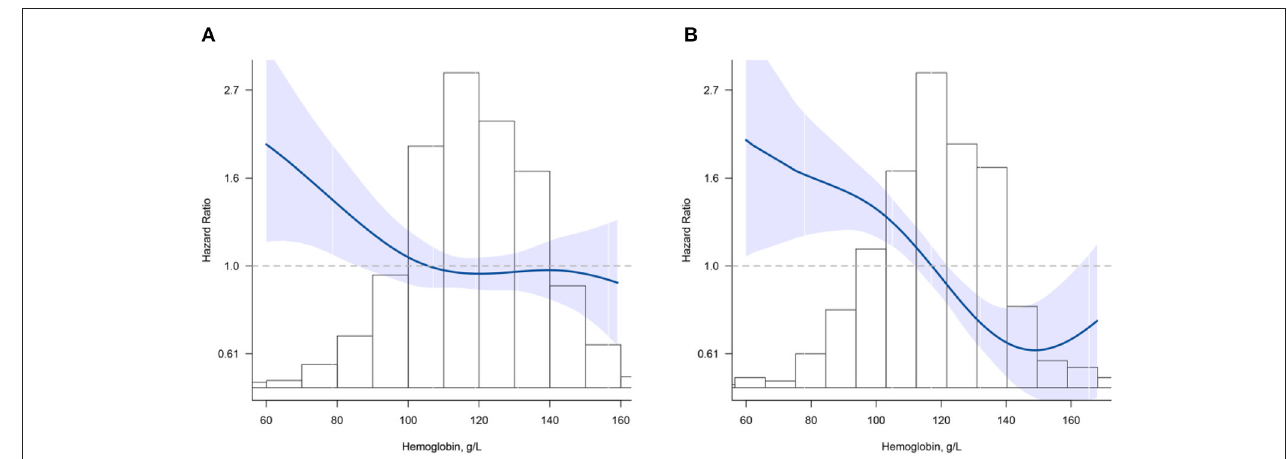
FIGURE 2 | Association between hemoglobin (Hb) and all-cause mortality according to cognition impairment. (A) normal cognitive group; (B) cognition impairment group. Hazard ratios are indicated by blue solid lines and 95% CIs by shaded areas. Histogram represents the distribution of Hb. Model was adjusted for age, sex, education, marital status, ethnicity, current smoker, current drinker, body mass index, albumin, high-sensitivity C-reactive protein, and chronic conditions (hypertension, diabetes mellitus, and chronic kidney disease) using restrict cubic